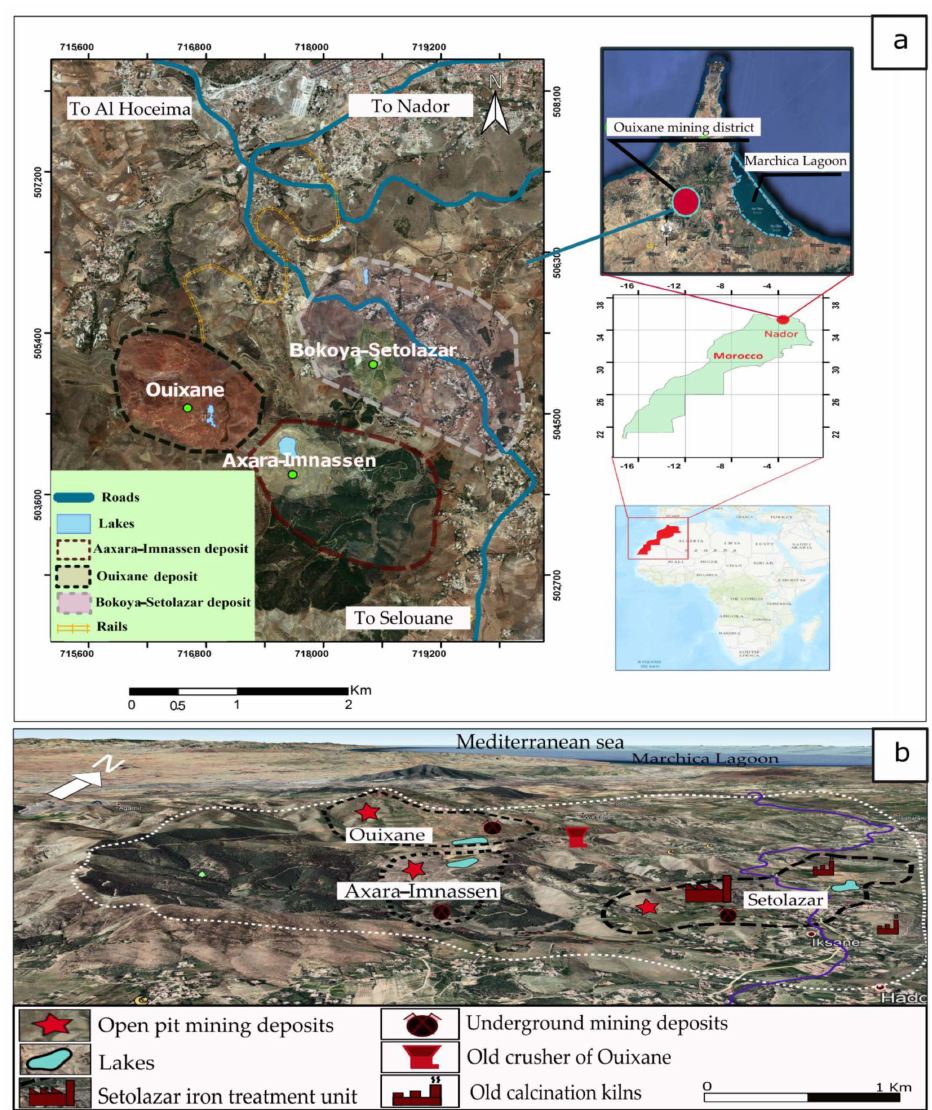
Figure 1. Geographical setting ( a ) and 3D satellite view ( b ) of the Ouixane iron mining district (northeast of